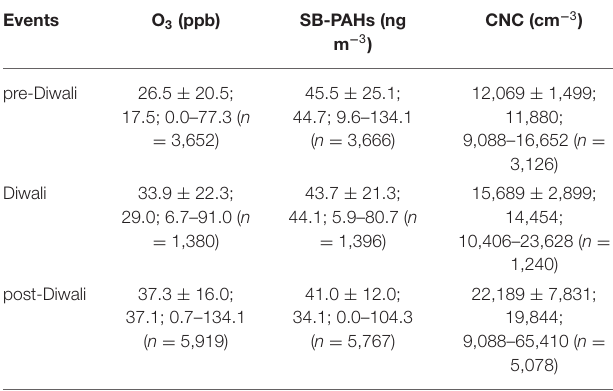
TABLE 3 | Concentration [Avg. ± SD; median; range (no. of samples)] of O 3 , SB-PAHs and CNC during the three events (pre-Diwali, Diwali, and